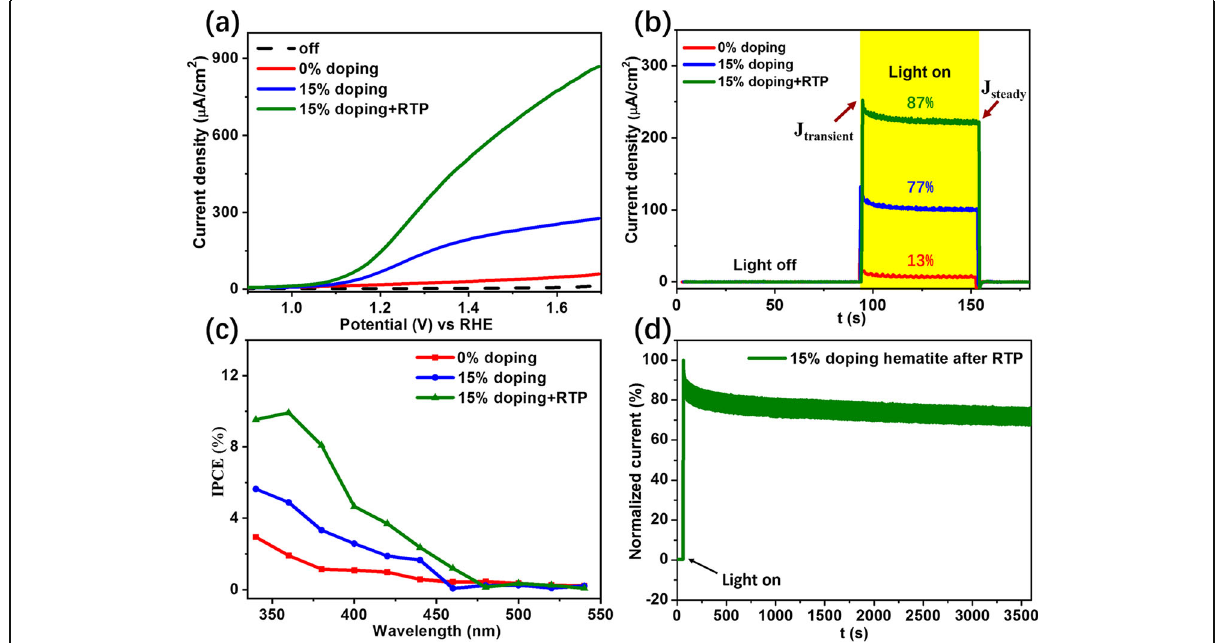
Fig. 5 a J-V curves. b Transient current density at 1.23 V RHE under chopped one-sun illumination. The calculated transfer efficiencies are also indicated as a percentage. c The IPCE spectrum at 1.23 V RHE . d The normalized photocurrent at 1.23 V RHE of the Sn-doped hematite photoanode with